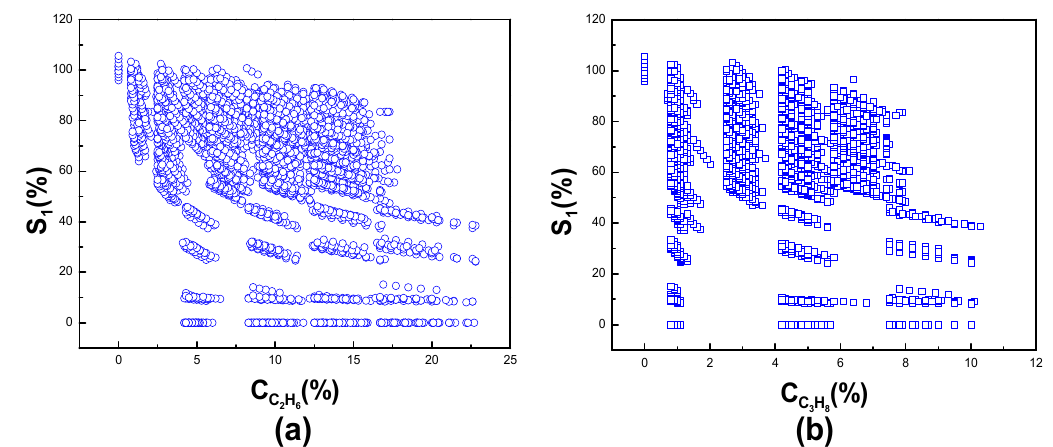
Figure 7. The cross-sensitivity of ( a ) ethane and ( b ) propane to methane.